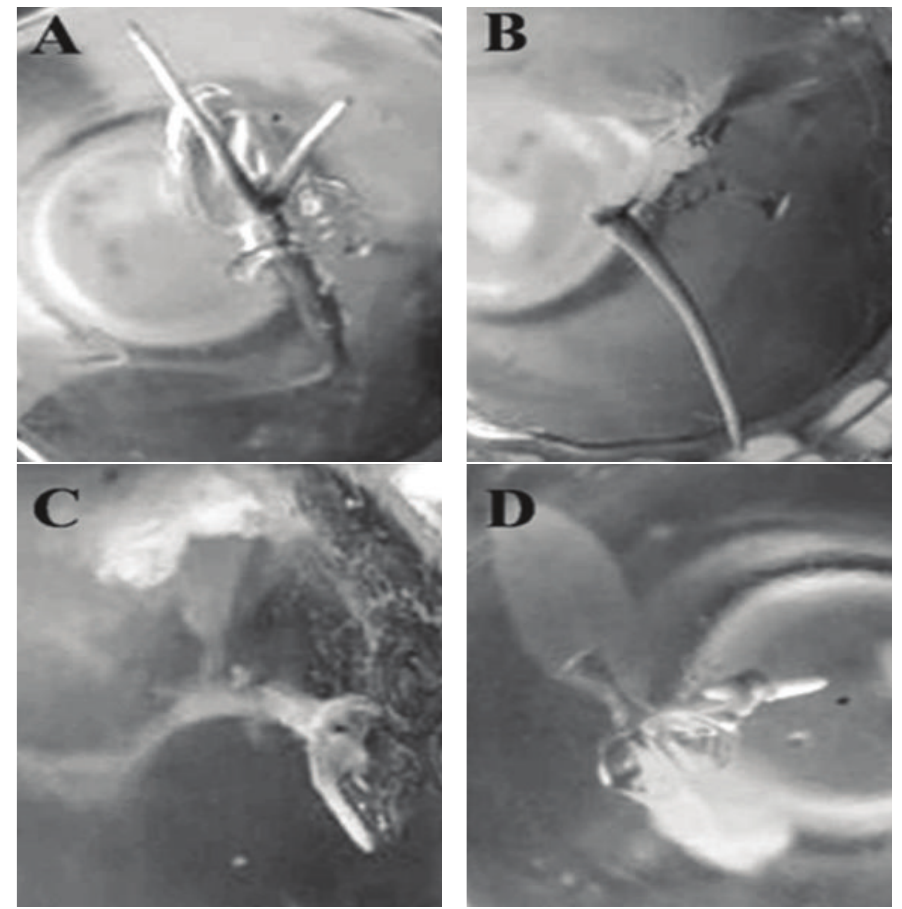
Figure 10: Inoculation of endophytic S. aquimarina SjAM16103 in A . marina (root growth) ( in vitro ). (A and B) Endophytic S. aquimarina SjAM16103 inoculated explants; (C and D) control explants.